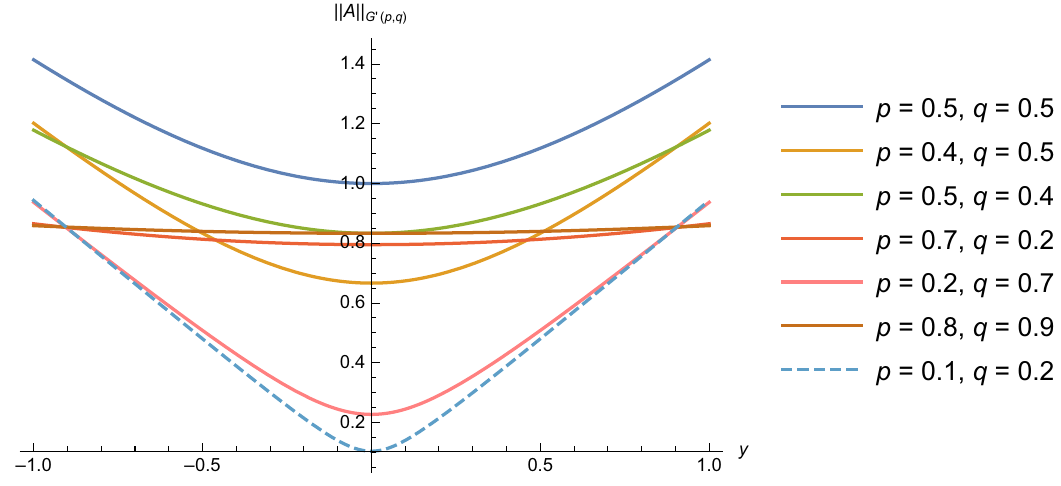
we have ) (cid:2) ≤ 1 < (cid:2) s (σ (cid:2) s (σ , σ , σ X Y Z M 3322 so there exist incompatible dichotomic Pauli measure- ments that do not violate the pure-correlation I inequality [8].